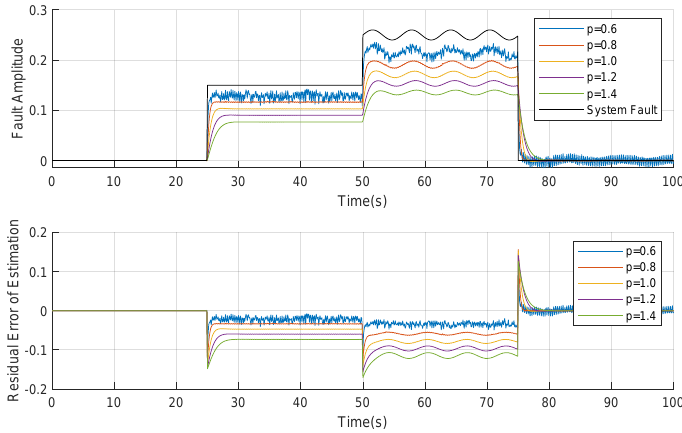
Figure 4. Fault estimation of nonlinear observers with different parameters.